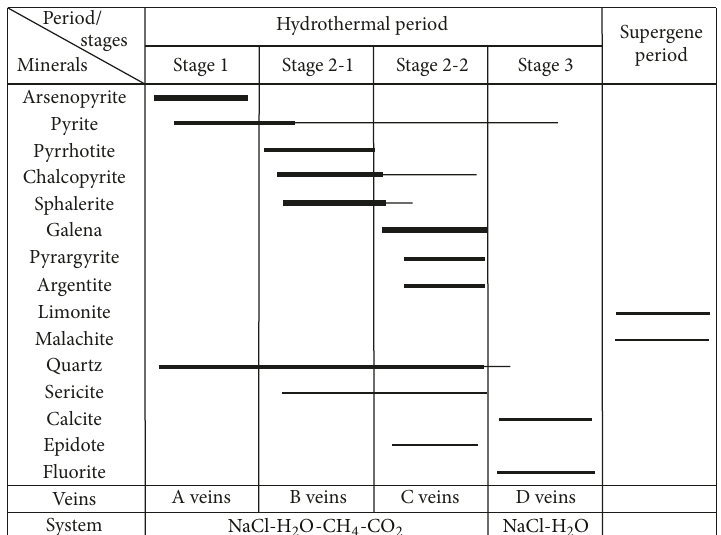
Figure 4: Mineral paragenesis for the Bairendaba Ag-Zn-Pb deposit.